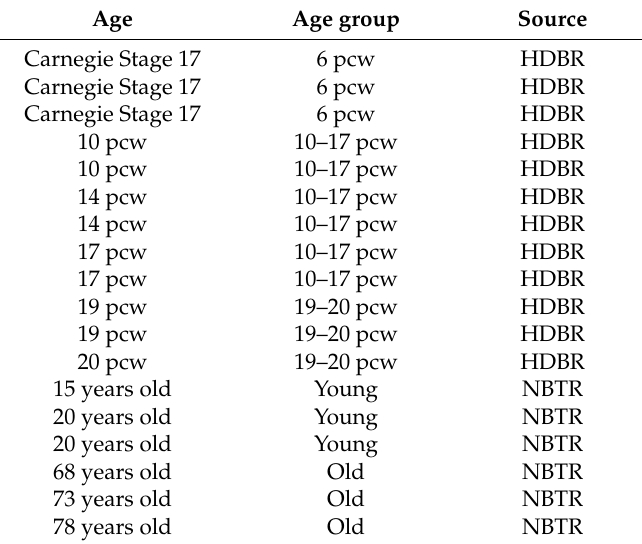
Table 1. Description of brain tissues